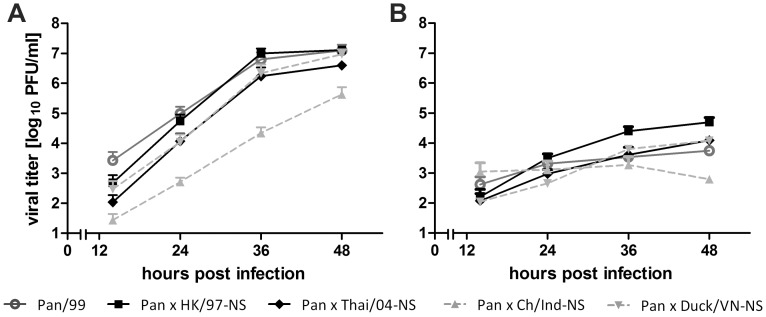
Replication of reassortant Pan/99 (H3N2)×H5N1-NS viruses in lung epithelial cells.(A) A549 cells were infected with the indicated Pan/99 (H3N2) wild-type and reassortant viruses carrying a H5N1-NS segment (MOI = 0.01). Aliquots of the supernatants were taken at the indicated time points and viral titers were determined by plaque titration. Mean data of at least two independent experiments+SEM are shown. (B) Virus growth on IFN-α treated A549 cells (500 IU/ml, 6 h before infection (MOI = 0.01) and during virus growth) was determined as described in panel A. Shown are the average results of two independent experiments+SEM.